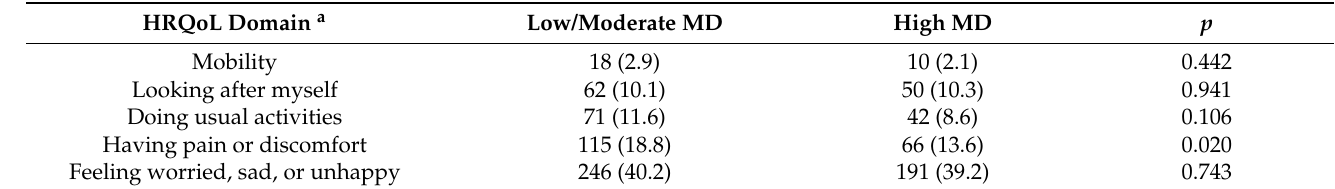
Table 2. Association between Mediterranean diet adherence and problems in different dimensions of health-related quality of life.